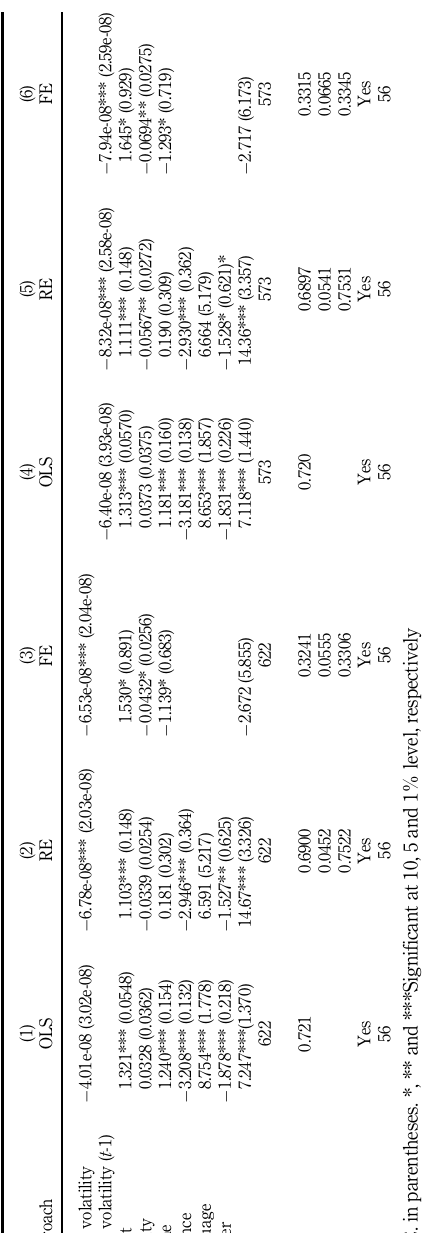
estimations using conditional variance of exchange